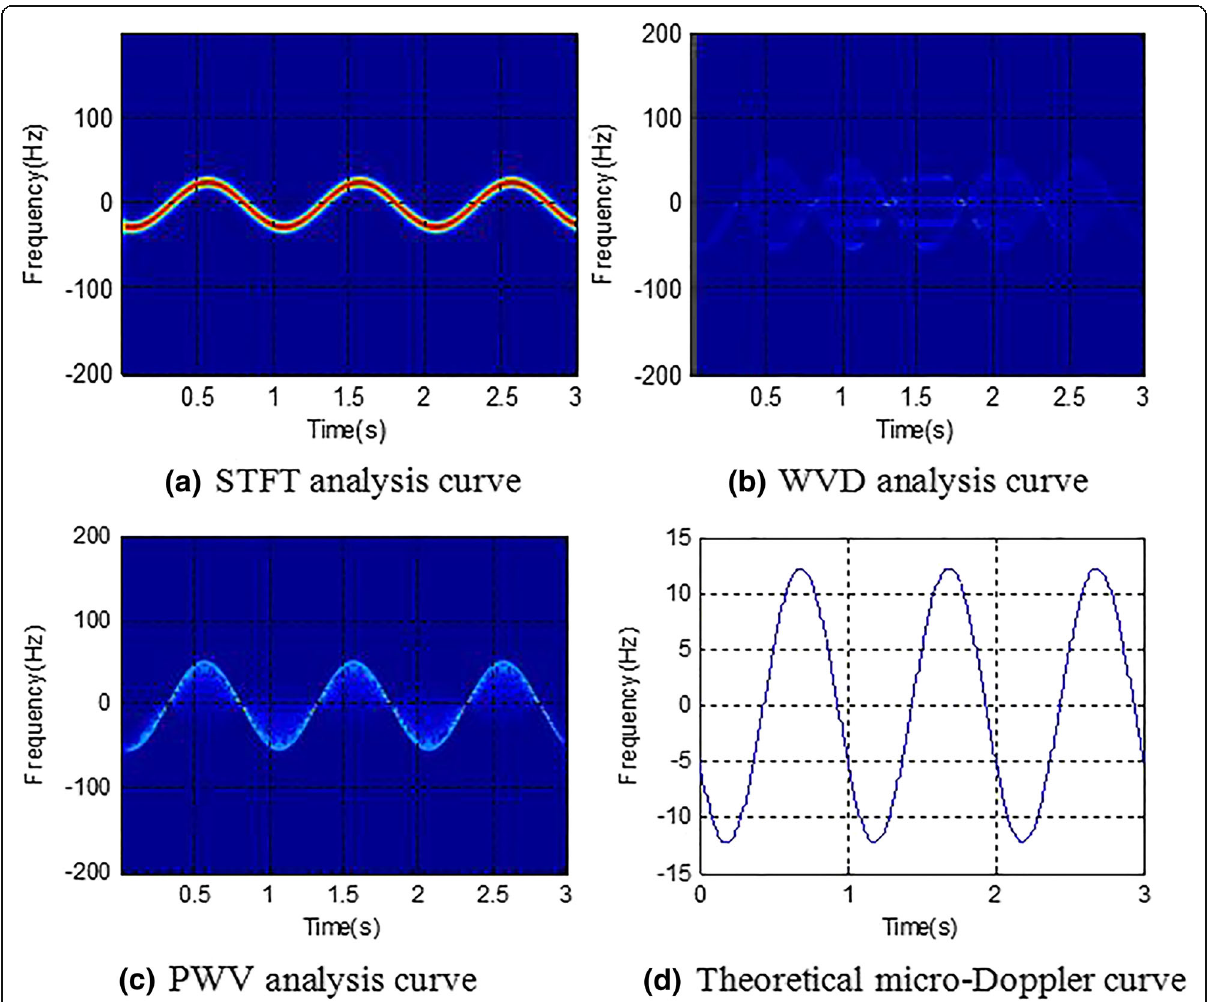
Fig. 2 Spin-fretting model time-frequency analysis m-D graph. a STFT analysis curve. b WVD analysis curve. c PWV analysis curve. d Theoretical micro-Doppler